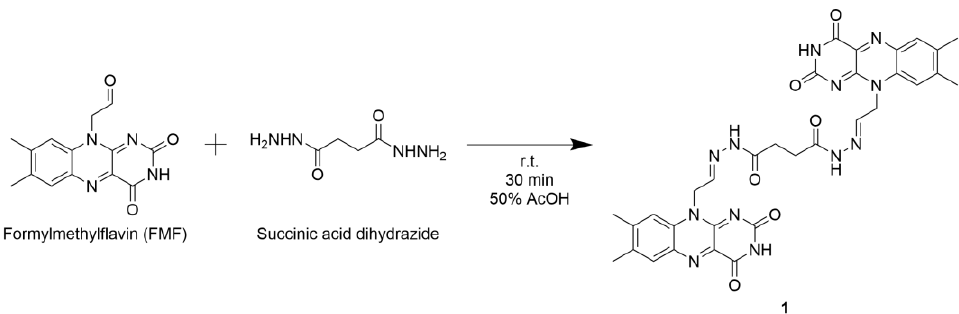
Figure 1. Synthesis of N ’ 1 , N ’ 4 -bis(2-(7,8-dimethyl-2,4-dioxo-3,4-dihydrobenzo[ g ]pteridin-10(2 H )- yl)ethylidene)succinohydrazide ( 1 ).